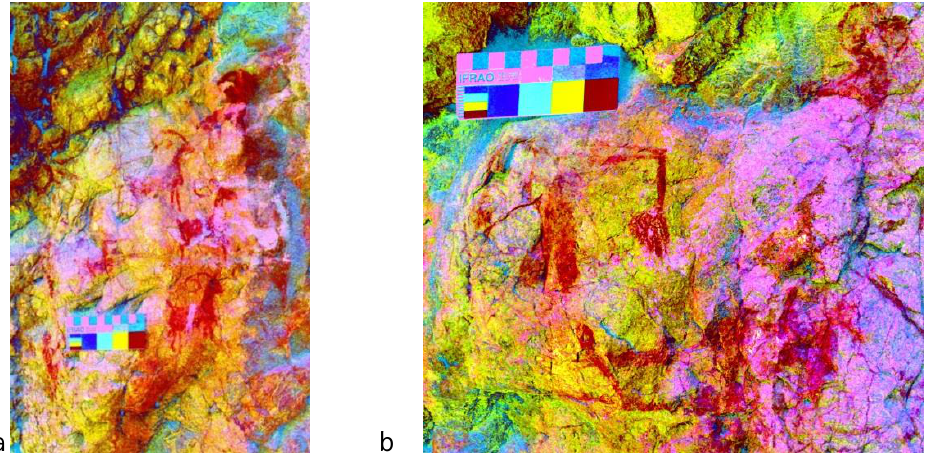
Figure 5. Depictions from Site II. ( a ) Zoomorphs (presumably ibexes). ( b ) Anthropomorphs and an unknown shape, probably a ploughing depiction (both photographs enhanced using Dstretch).